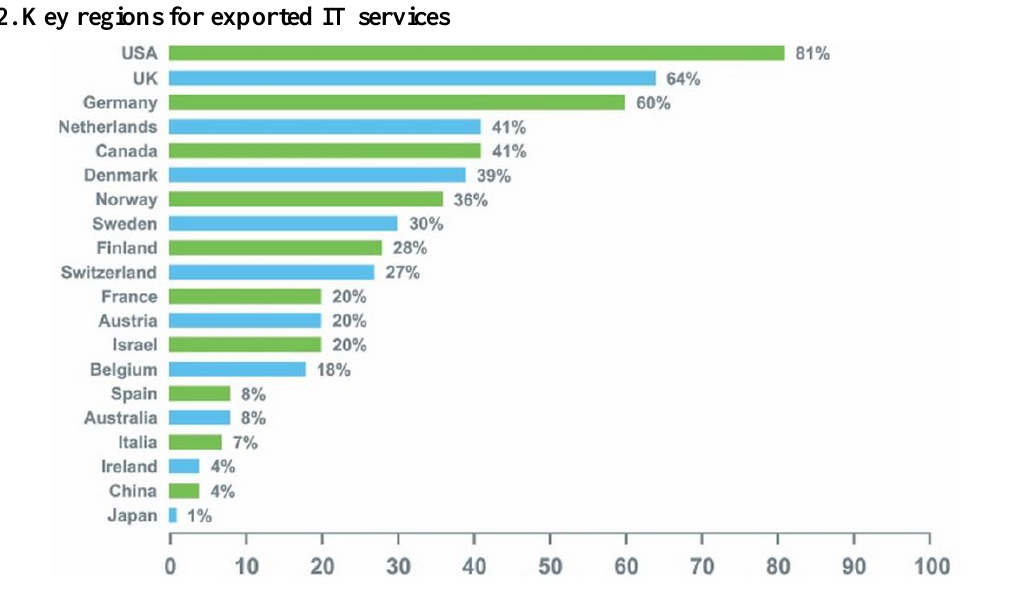
Figure 2. Key regions for exported IT services